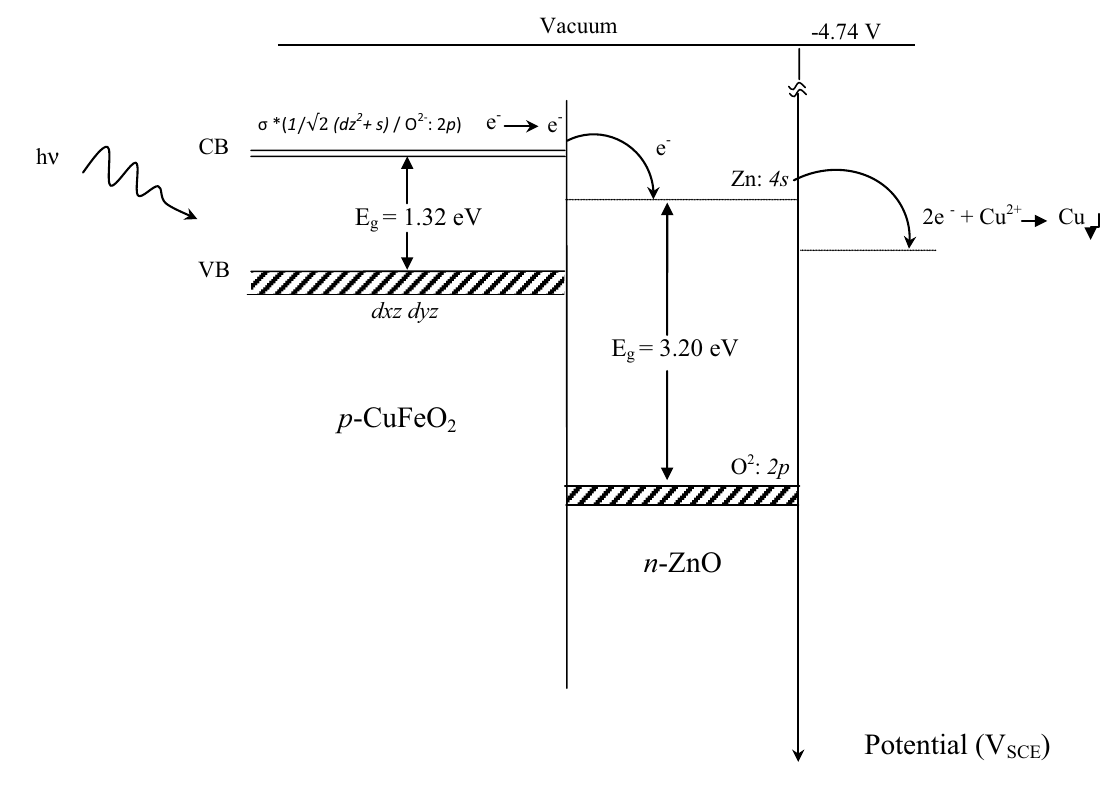
Fig. 4 Energy diagram of the hetero-system p -CuFeO